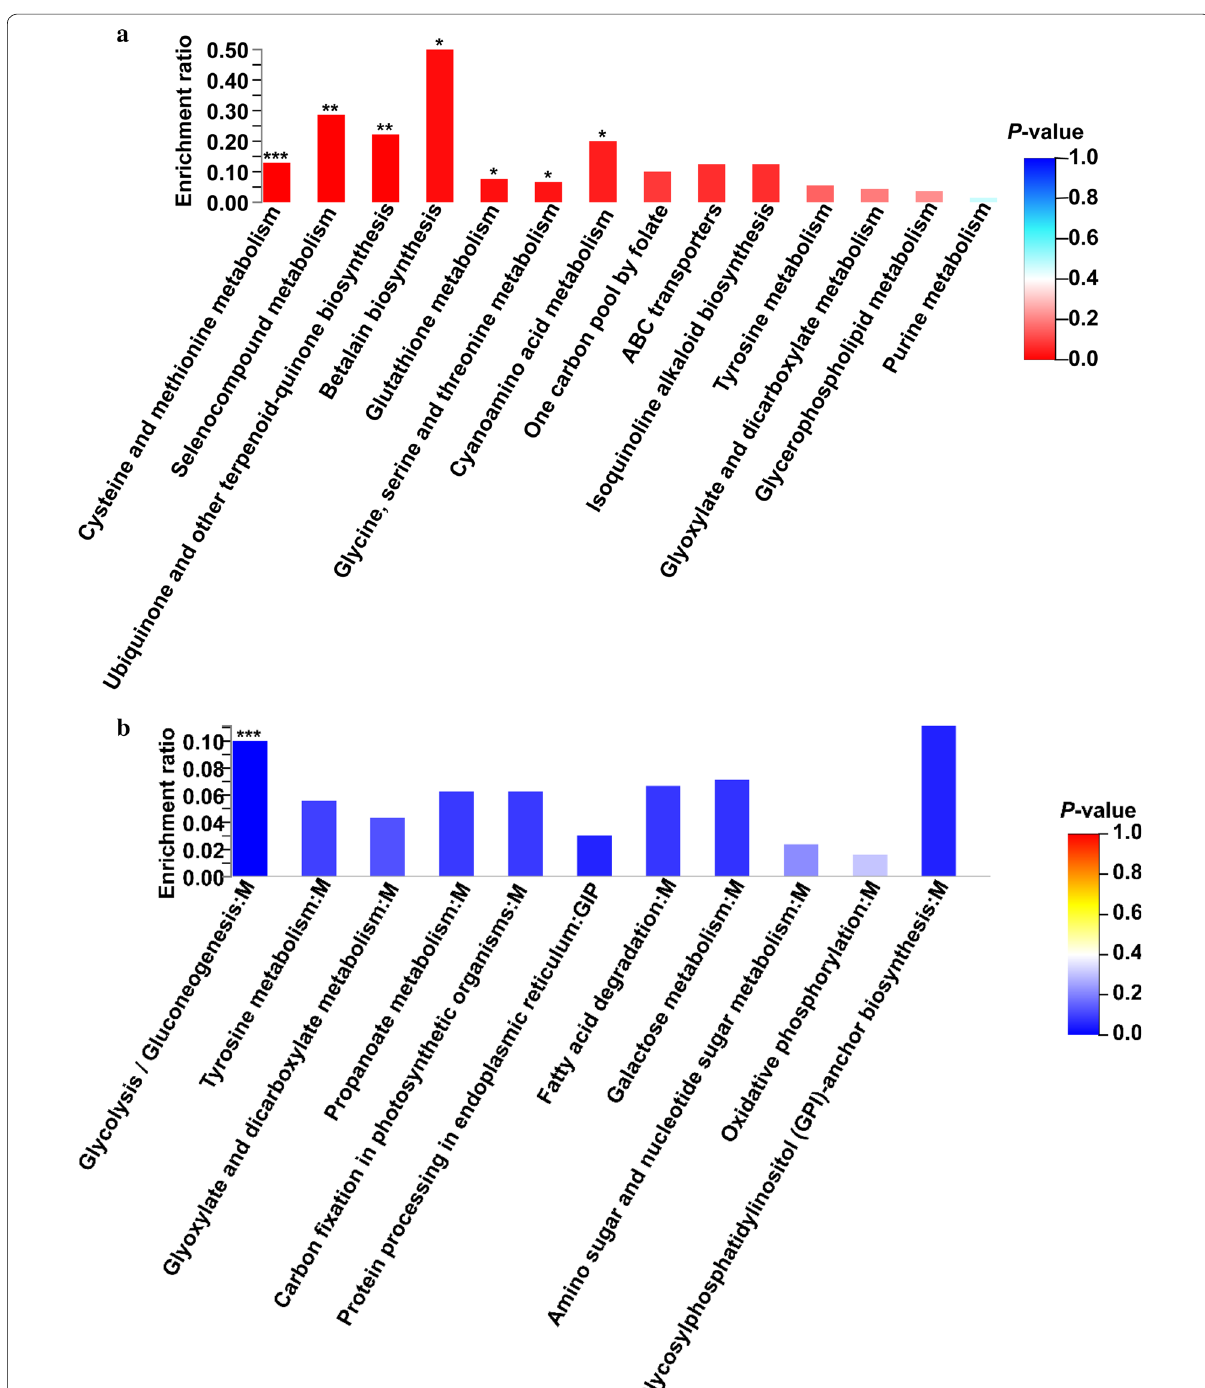
Fig. 5 Enriched pathways of upregulated ( a ) and downregulated ( b ) proteins on day 10 based on KEGG annotation. * P < 0.05, ** P < 0.01, *** P <